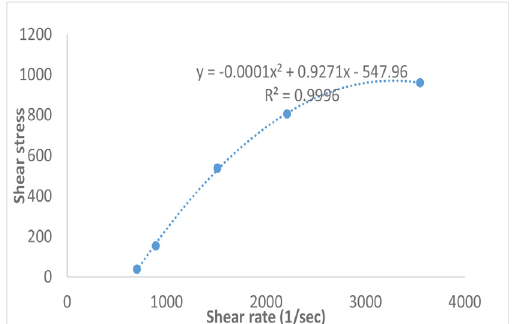
Fig. 5. profile viscosity of Sample F1: Semi-Solid Containing HPMC with Water (data are the average of 3 repetitions/replications).